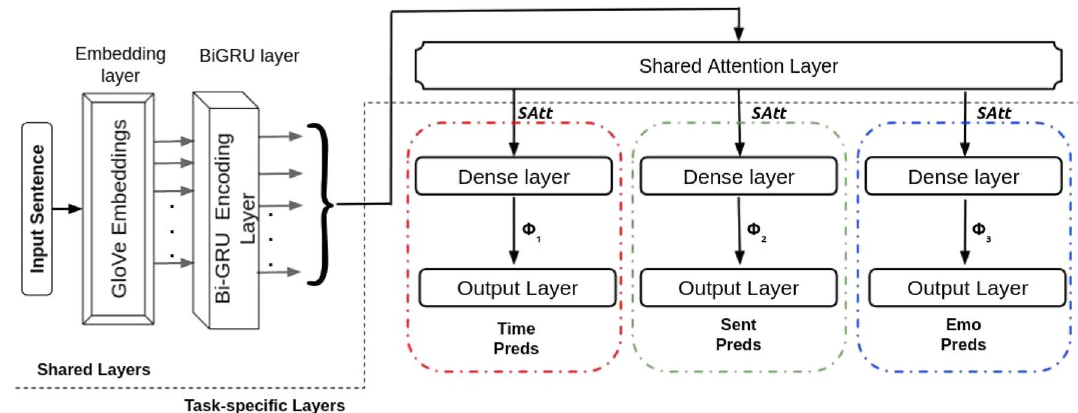
Figure 2. Architecture of basic multitask system with distinct shared and task-specific layers. Colour coded red, green and blue dotted lines depicts the three independent task-specific sub-networks.